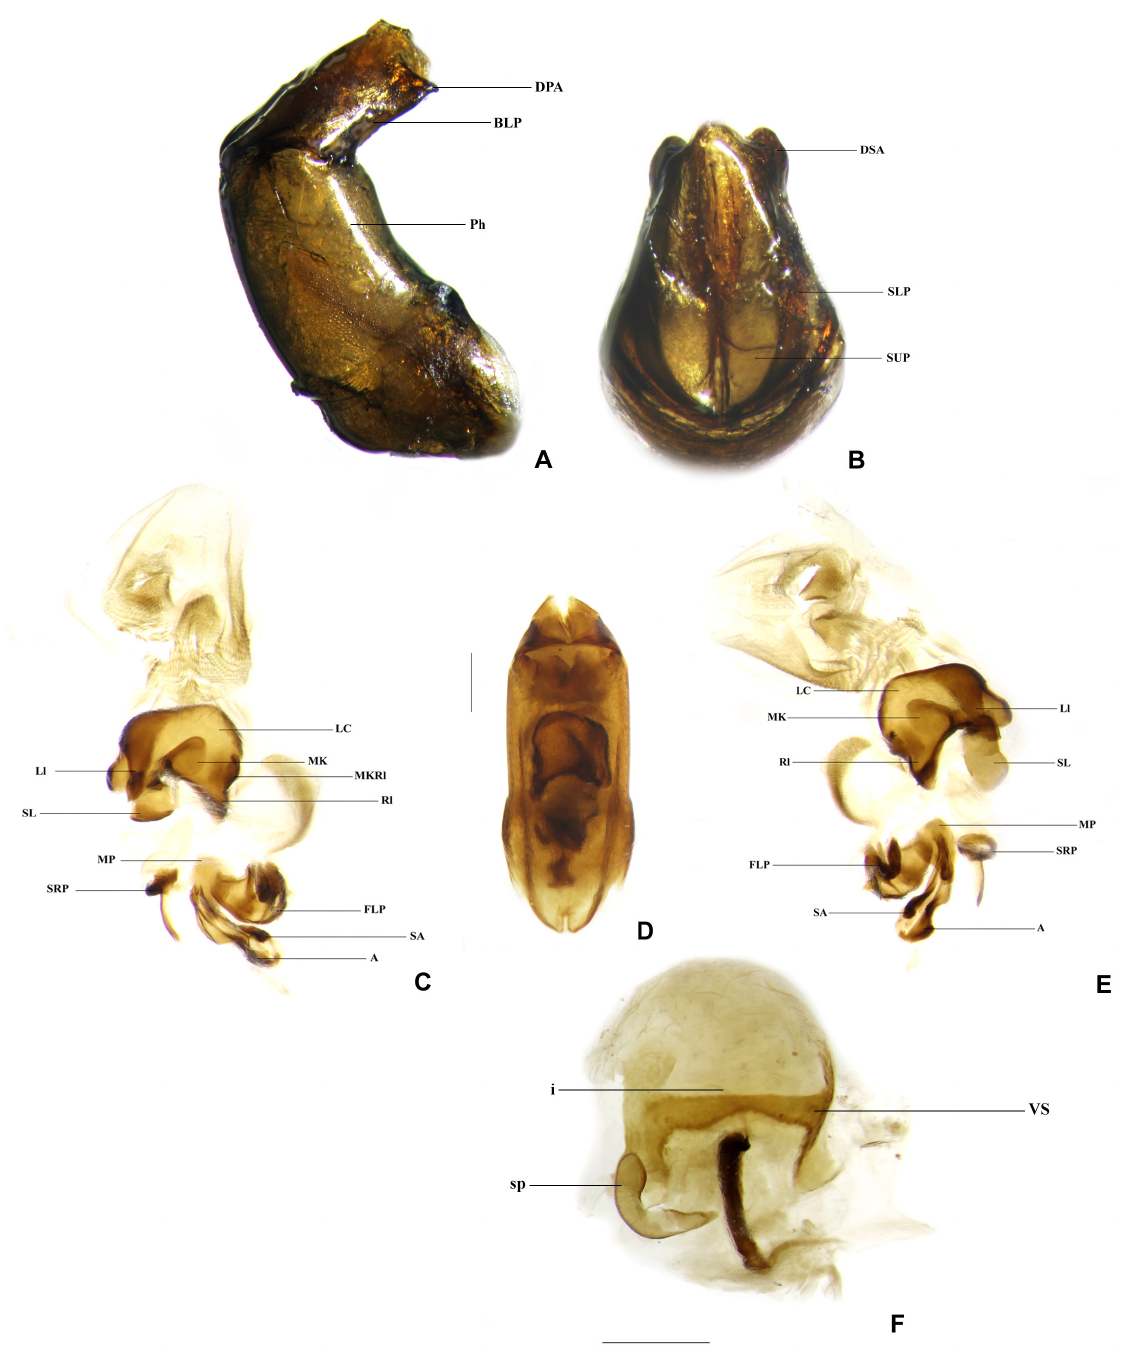
Fig. 1. A–B . Lateral and dorsal habitus of the parameres (Abbreviations: Ph = phallobase; DPA = distal-inferior paramerite; BLP = basolateral plate; SUP = superior plate; SLP = supralateral plate; DSA = distal-superior area). C, E . Frontal and posterior side of the internal sac (Abbreviations: LC = lamella copulatrix; MK = medial keel of the lamella copulatrix; MKRl = medial keel of the right lobe; SL = secondary lamella; Ll and Rl = left and right lobe of the lamella copulatrix; FLP = fronto-lateral peripheral lamella; MP = medial peripheral lamella; SRP = superior right peripheral lamella; A = axial lamella; SA = subaxial lamella). D . Rear view of the aedeagus with internal sac at rest; posterior side of the internal sac in transparency. F . Female genitalia (Abbreviations: i = infundibulum; sp = spermatheca (receptaculum seminis); VS = ventral sclerotization of the vagina). Scale bars: 0,05